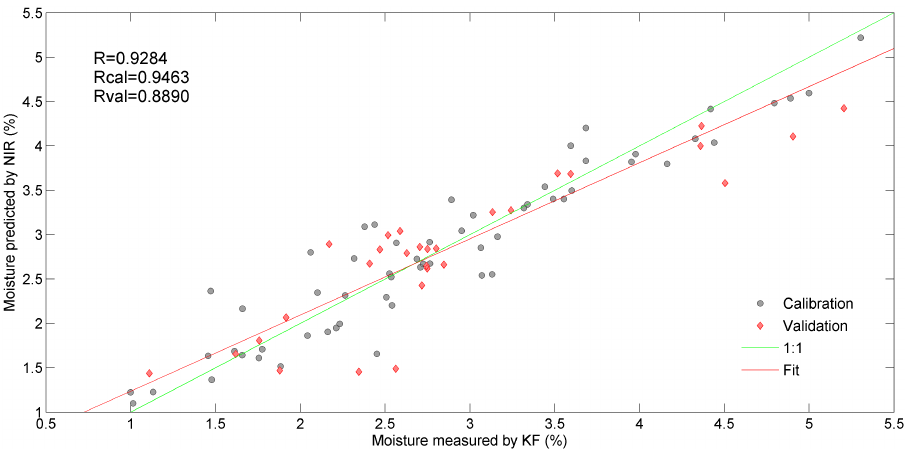
Fig. 3. Relationship between the reference and predicted